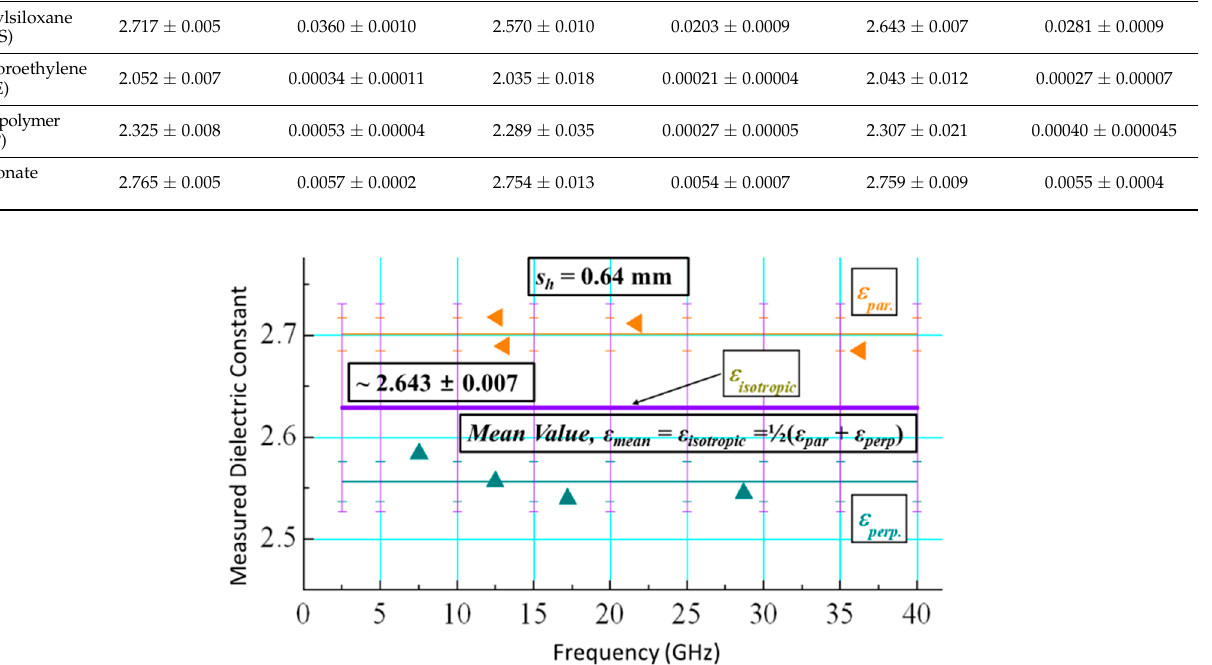
( b ) Figure 7. Dielectric parameters: dielectric constants ( a ) and loss tangents ( b ) of PDMS at various temperatures (5- 15 GHz). Table 4. Empty resonator (R A and R B ) parameters (units GHz, mm, S/m, ° C) at di ff erent tempera- tures. R A (TE 011 )